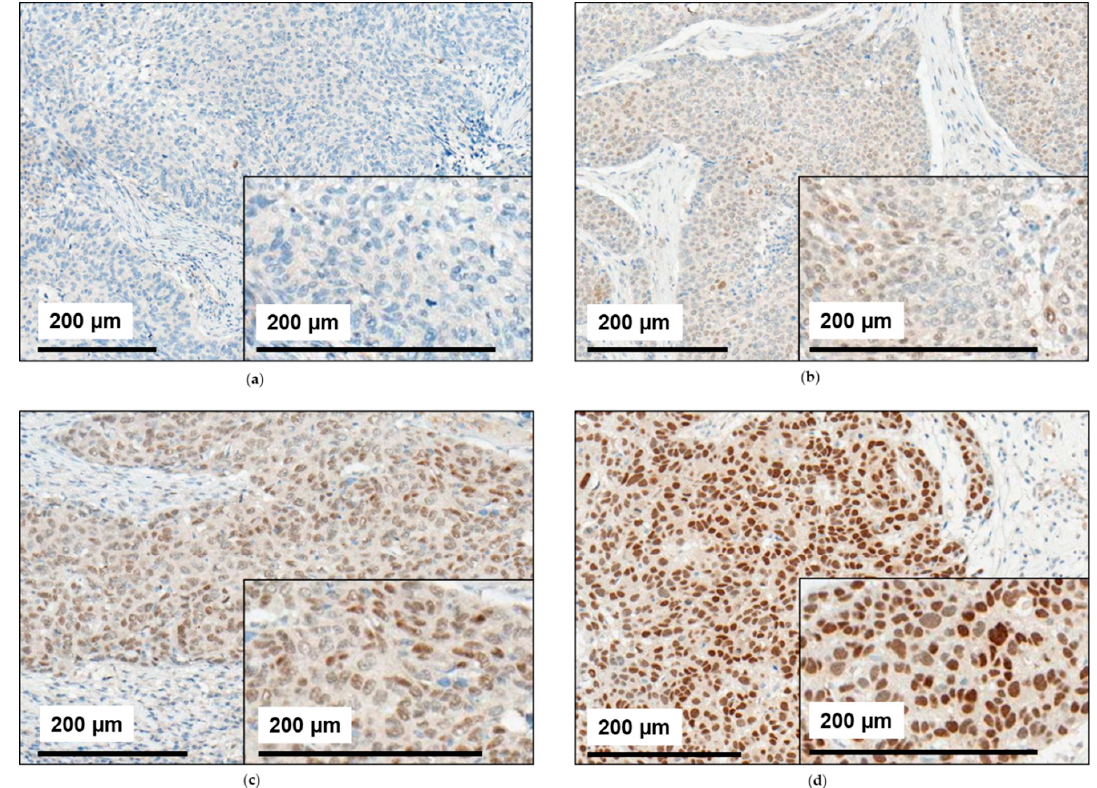
Figure 1. Staining patterns for NR2F6 in HNSCC. The HNSCC tissue from our cohort was immunohistochemically assessed for NR2F6 expression. ( a ) Some tumors showed no NR2F6 expression. In other tumors, the mean NR2F6 expression was ( b ) low, ( c ) medium, or ( d ) high. Some HNSCC also showed an inhomogeneous NR2F6 expression with ( b , c ) positive and negative cells.